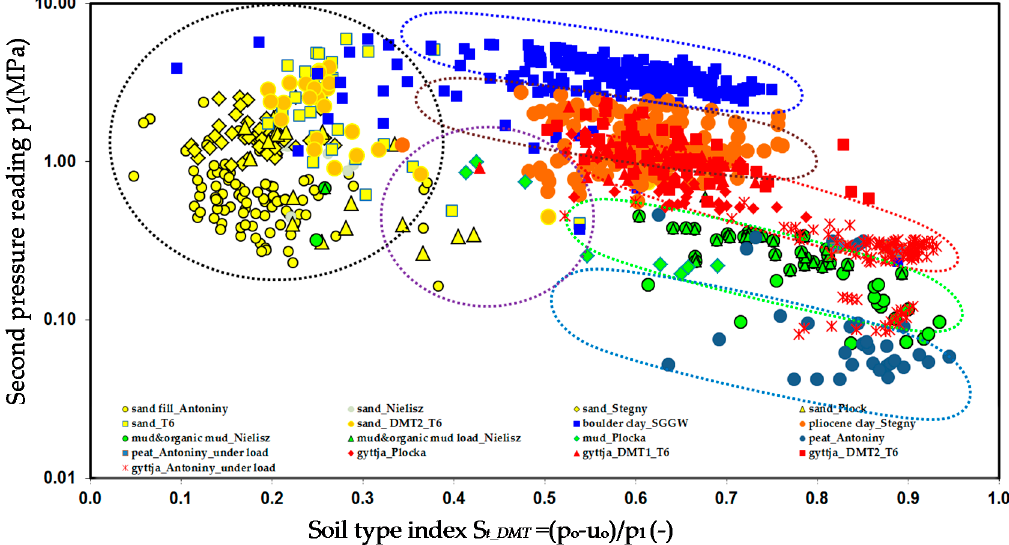
Figure 10. Variation of p 1 with soil type index S t_DMT = ( p 0 − u o )/ p 1 .